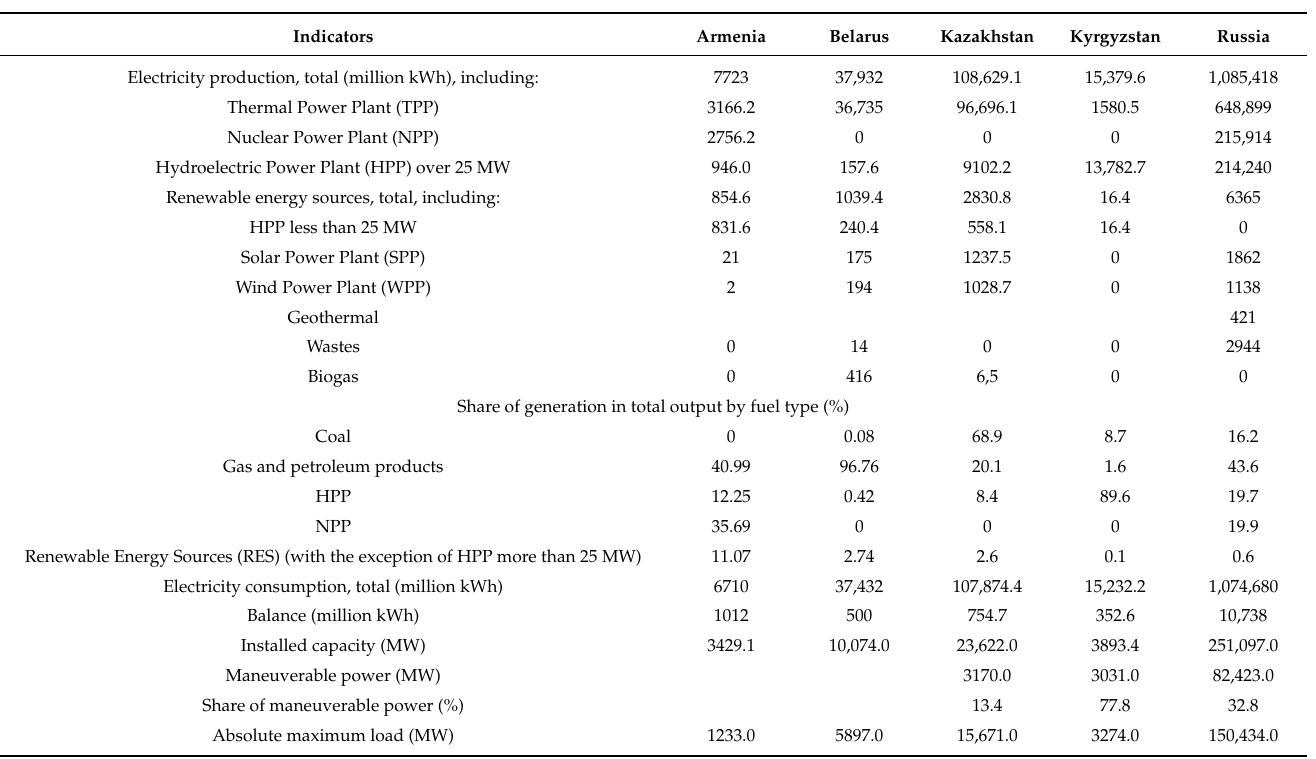
Table 2. Main technical and economic indicators of the energy systems of the participating countries of the EAEU common electricity market for